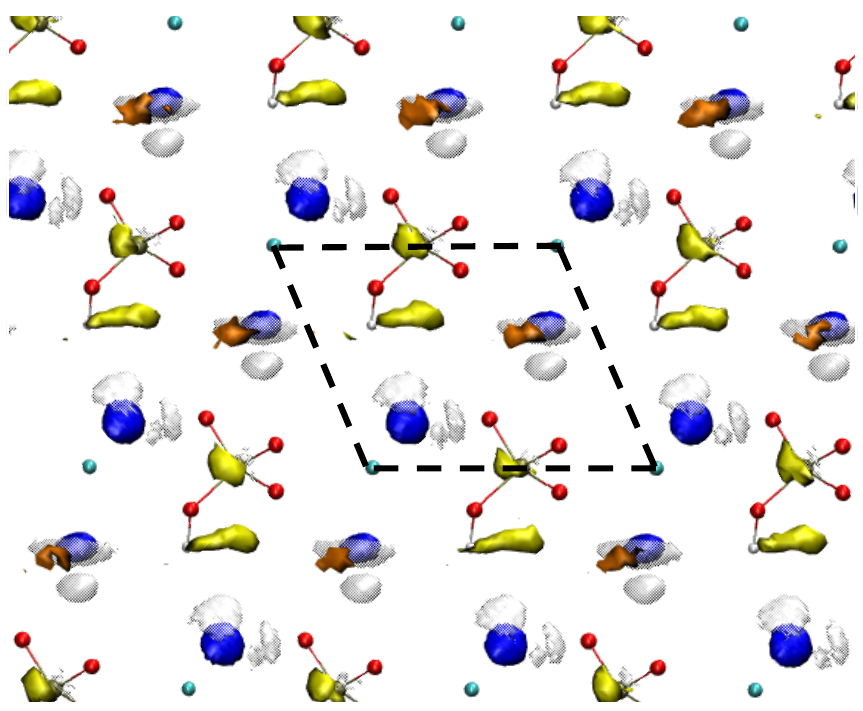
Figure 5. Top view of the 3D atomic structure of the flat brushite-water interface for the {010} plane. Average positions of the crystal are represented with a ball-and-stick model with only the top layer of the phosphate bilayer shown and calculated density isosurfaces for the first three water layers. For average positions, H is white, O is red, P is tan, and Ca is cyan. In the water density isosurfaces the first layer H is white and the first layer O is blue (both isosurfaces set to 2 atoms/Å 3 ), the second layer O is yellow (0.2 atoms/Å 3 ) and the third layer O is orange (0.05 atoms/Å 3 ). The surface unit cell is indicated with a dashed black